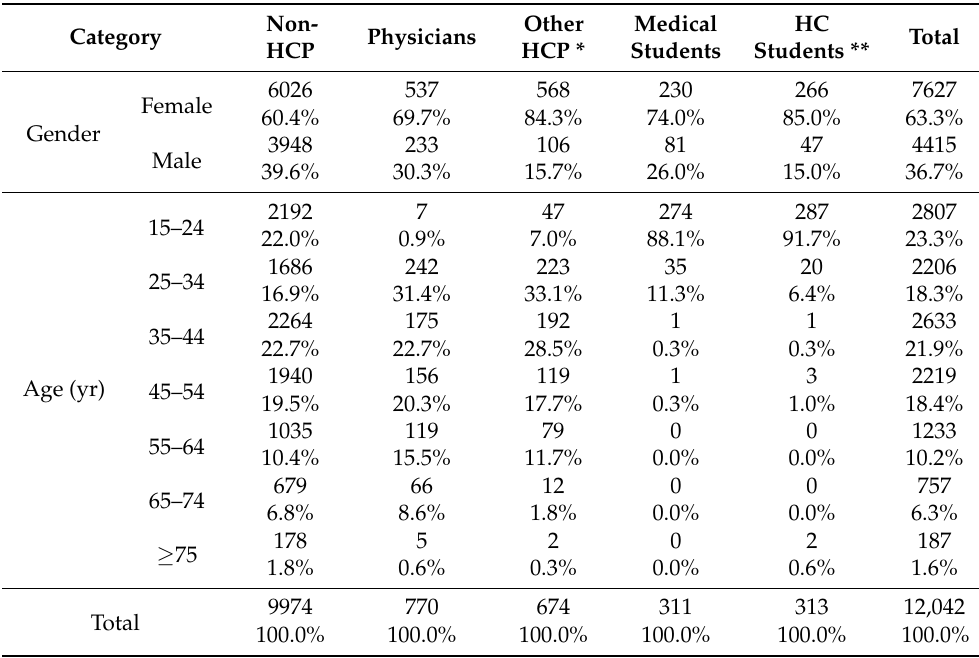
Table 1. Demographic data; percentages calculated within the column for gender and age separately (* nurses, caregivers, physiotherapists, pharmacists, psychologists, etc.; ** students of nursing faculties or high schools, other medicine-related fields of